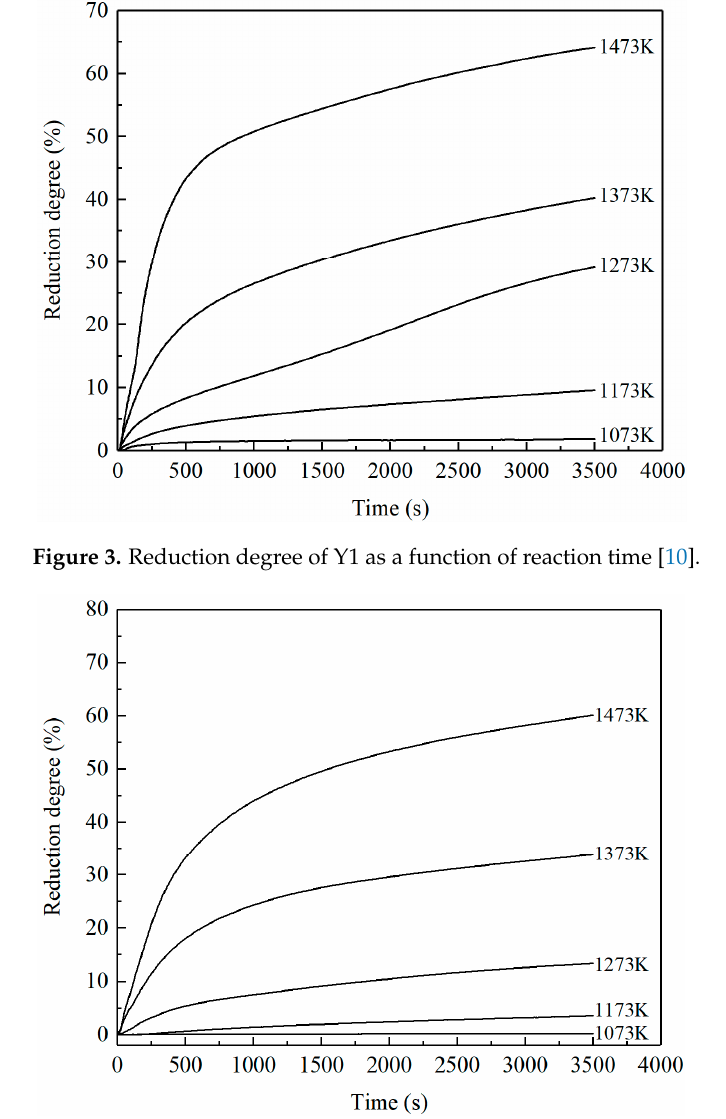
Figure 4. Reduction degree of Y2 (Al 2 O 3 addition) as a function of reaction time.